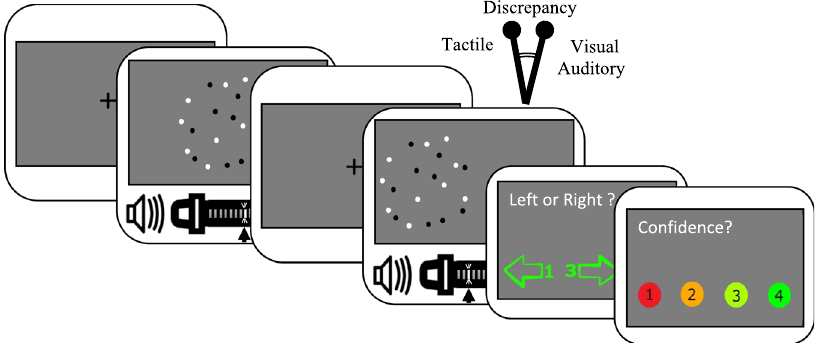
Figure 8. Time course of an exemplary trial: Subjects were presented a fixation screen for 800 ms, and then the first multimodal stimulus for 100 ms. Afterwards, another fixation screen was presented for 600 ms, and the second multimodal stimulus with a cue-conflict (spatial discrepancy of − 4° visual angle) was presented for 100 ms. Subjects were asked to report whether the second stimulus was to the left or right of the first one. They also reported their confidence on a scale of 1 (low confidence) to 4 (high